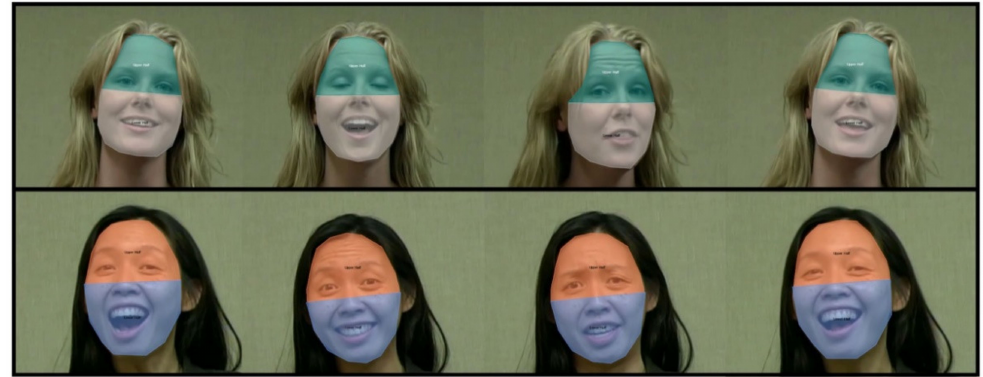
Figure 2. Examples of our dynamic AOIs for two of our stimuli. Note that the AOIs move with the face, so they capture the same region of the face even as the face